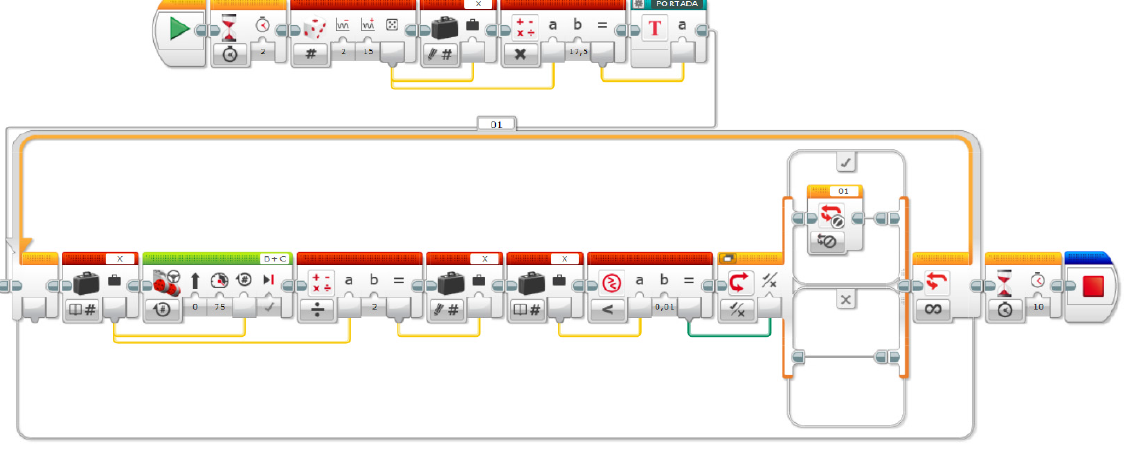
Figure 6. Program for the physical visualization of the Cauchy’s sequence